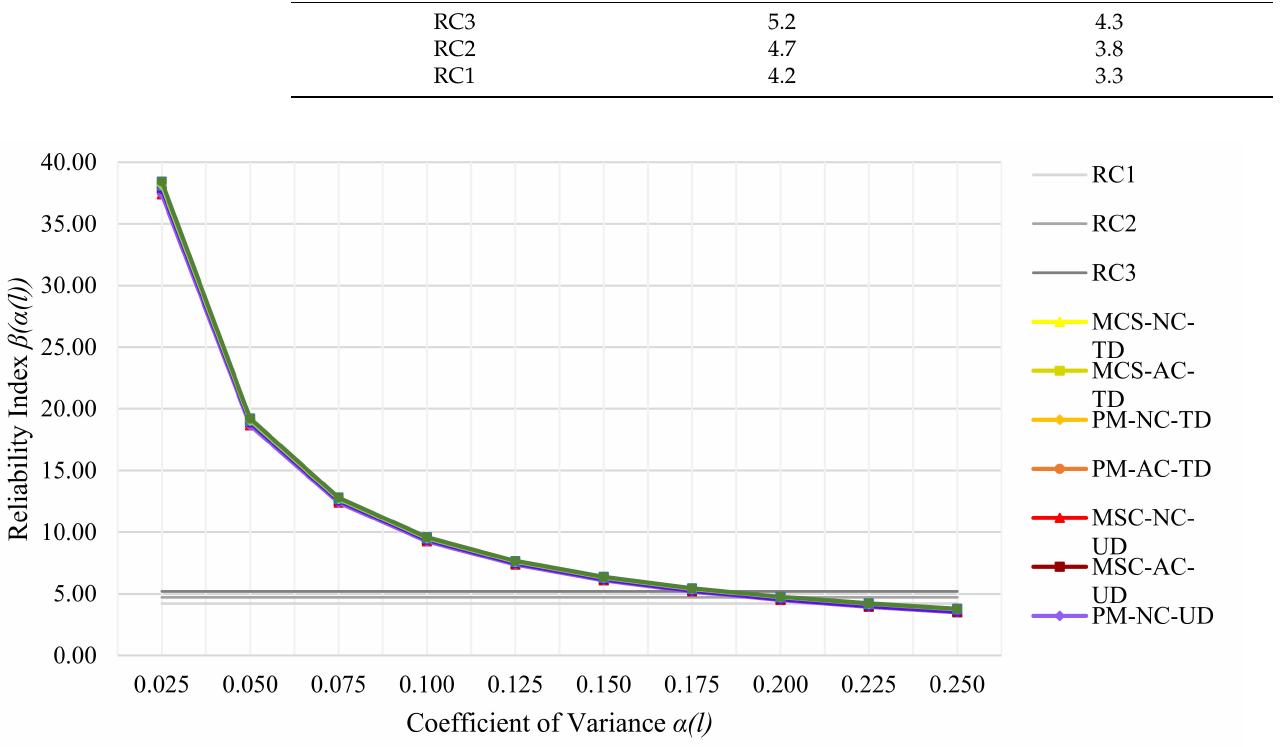
Figure 10. The reliability index β in the